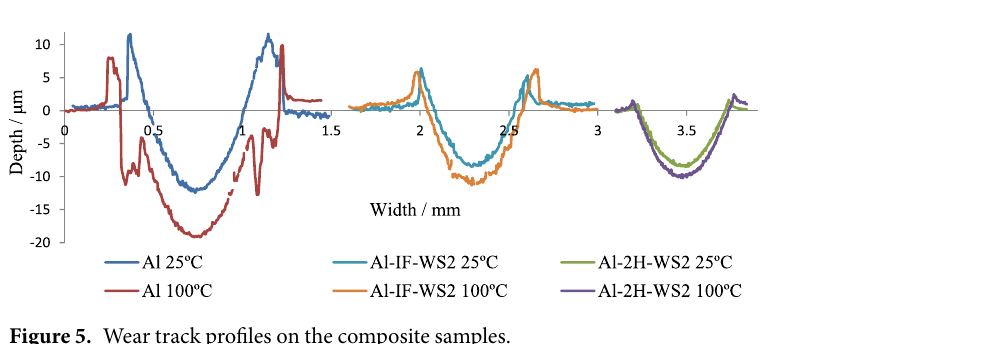
Figure 5. Wear track profiles on the composite samples.